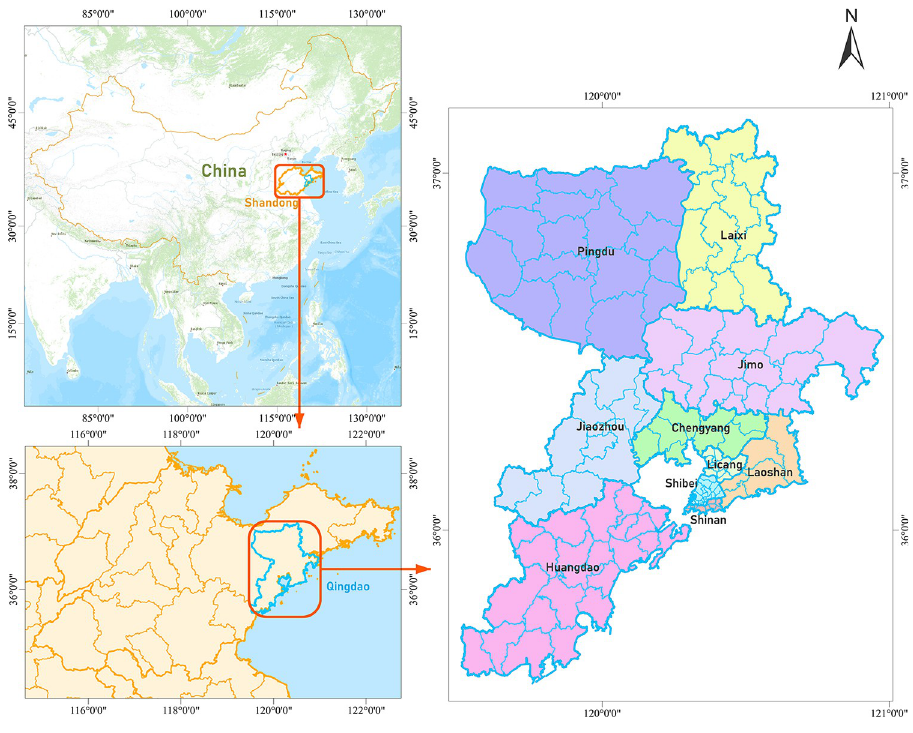
Fig 1. Qingdao geographical location map